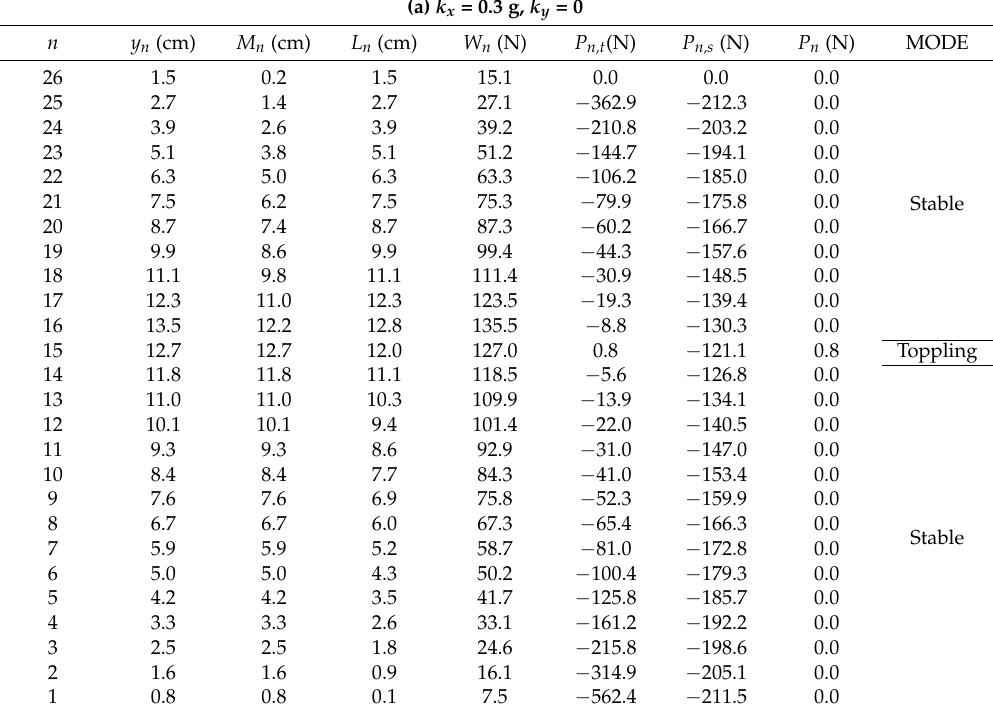
Table 4. The sheets from limit equilibrium analysis of slopes under seismic